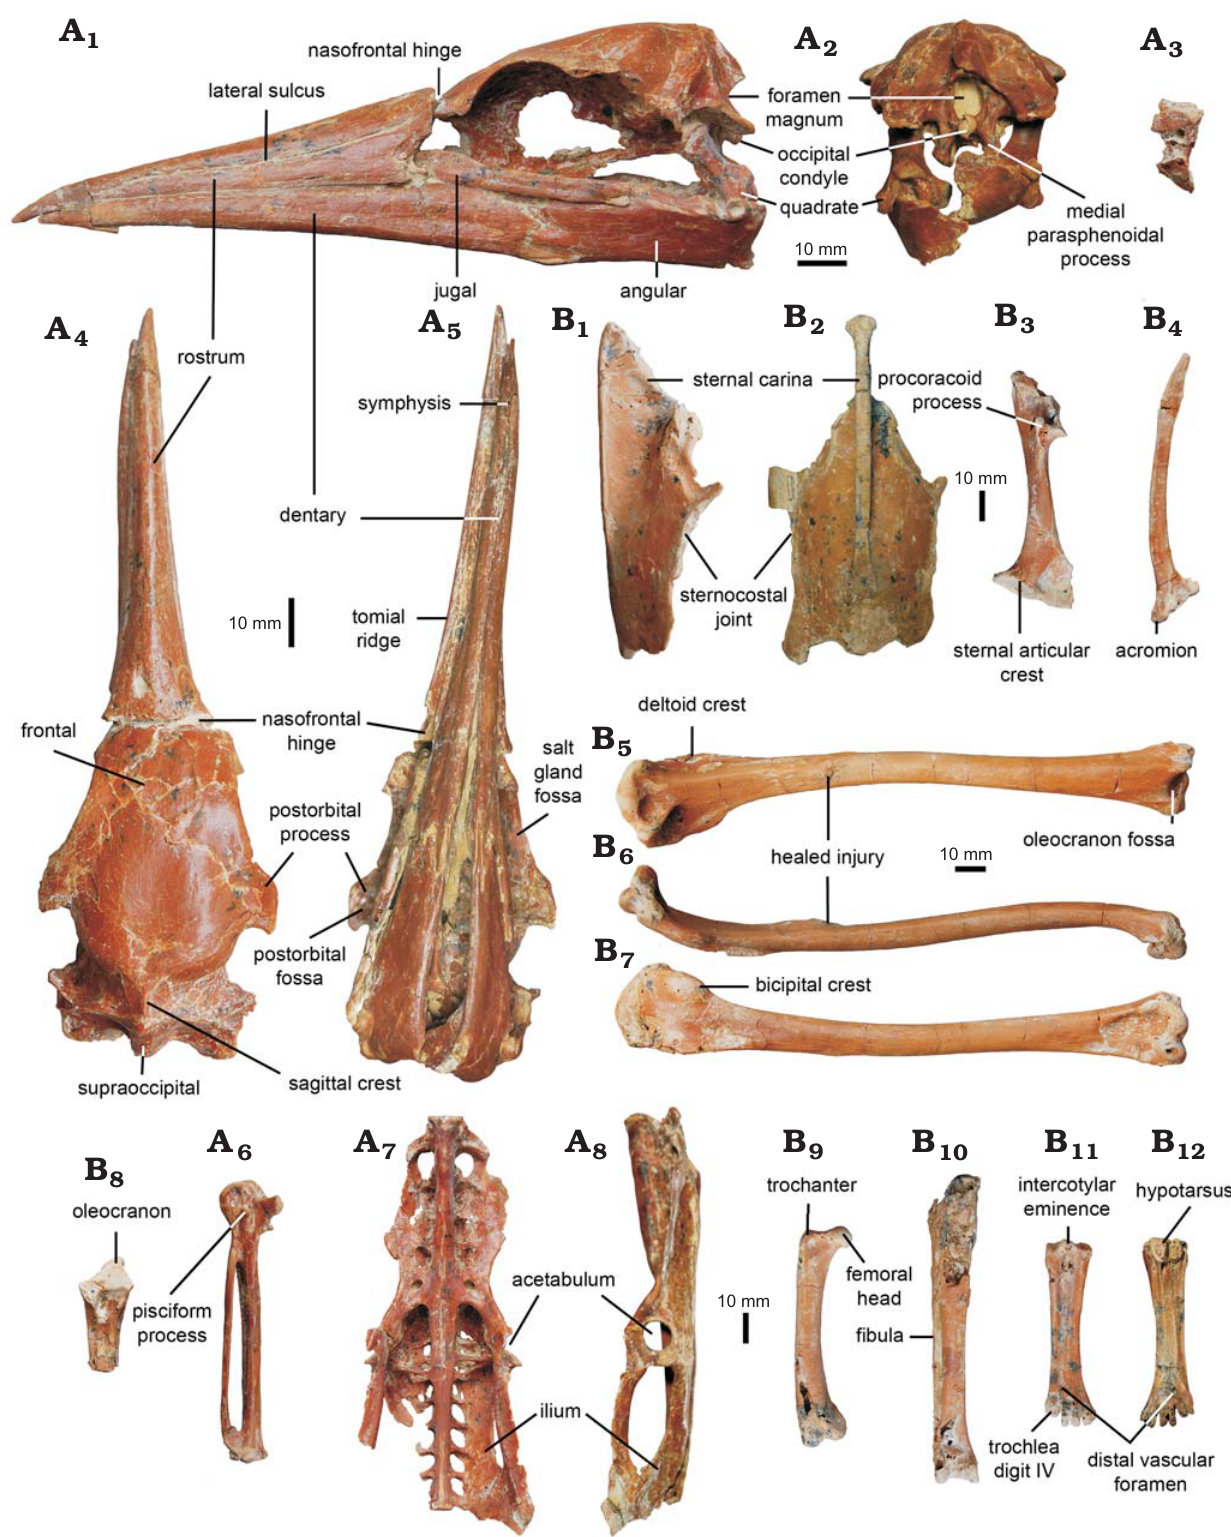
Fig. 3. Sulid bird Sula figueroae sp. nov. from Cerro Colorado locality, Peru, Pisco Formation, early Late Miocene. A . Holotype MUSM 2501. Skull in lat- eral (A 1 ), posterior (A 2 ), dorsal (A 4 ), and ventral (A 5 ) views. Isolated lacrimal in lateral view (A 3 ). Left carpometacarpus in ventral view (A 6 ). Synsacrum and pelvis in ventral (A 7 ) and lateral (A 8 ) views. B . Paratype MUSM 2502. Sternum in lateral (B 1 ) and ventral (B 2 ) views. Coracoid in (B 3 ) dorsal view. Left scapula in (B 4 ) lateral view. Right humerus in anterior (B 5 ), lateral (B 6 ), and posterior (B 7 ) views. Proximal portion of ulna in ventral view (B 8 ). Right femur in anterior view (B 9 ). Right tibiotarsus in anterior view (B 10 ). Right tarsometatarsus in anterior (B 11 ) and plantar (B 12 )